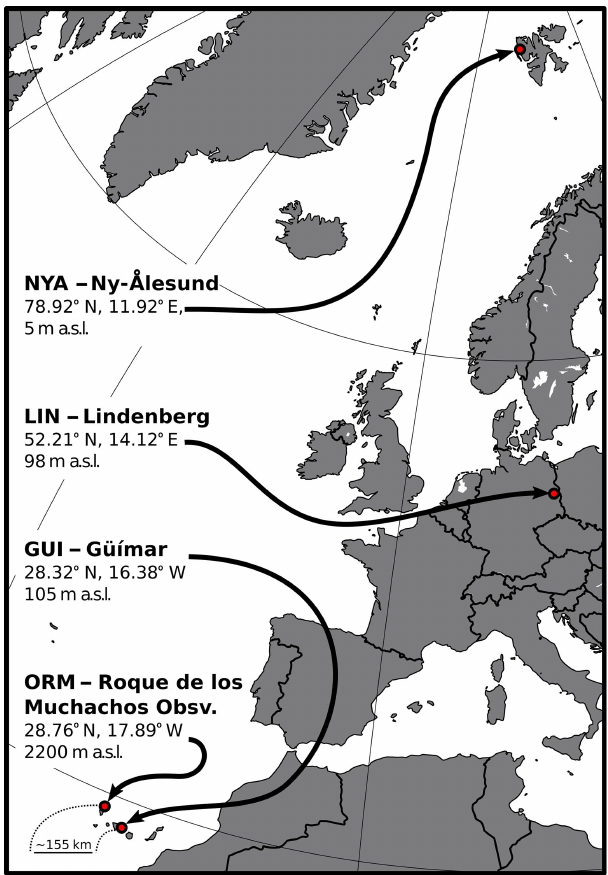
Figure 1. Location and height above the sea level of the four ra- diosounding launching points in the Canary Islands, Spain (ORM and GUI), separated by ≈ 155km, Lindenberg in Germany, and Ny-Ålesund, in the Svalbard Islands, Norway (source: Wikimedia